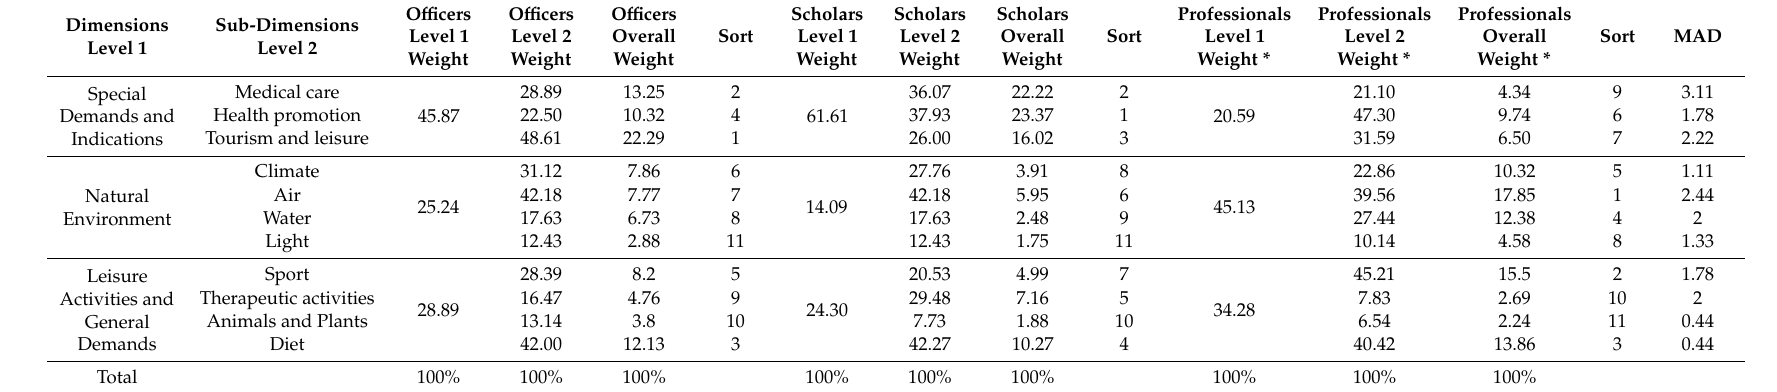
Table 2. Expert group assessments of health tourism